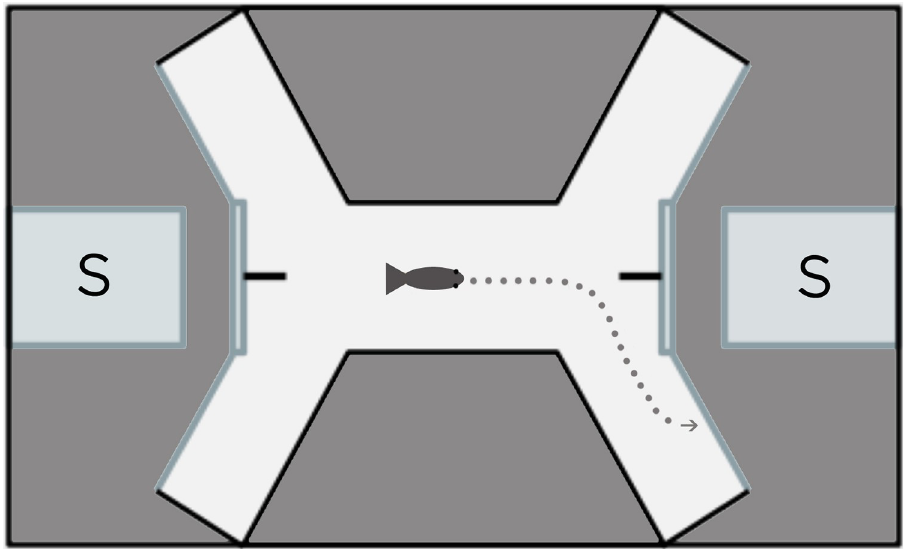
Fig 3. Mean laterality index scores (+- 2SE) across stimuli for the predator-free (Grande) and predator (Javilla) populations.